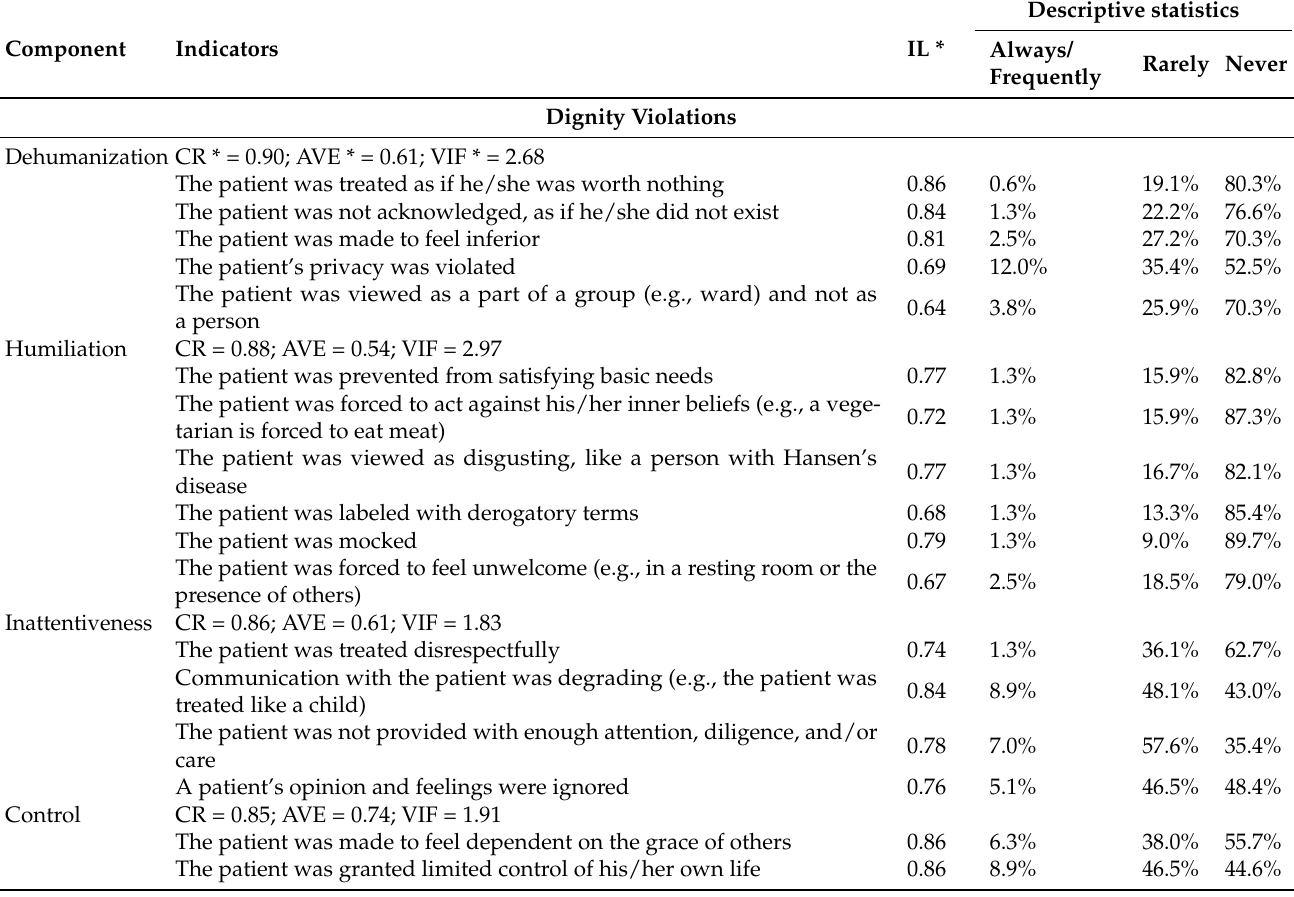
Table 1. Descriptive statistics, indicator loadings, and convergent